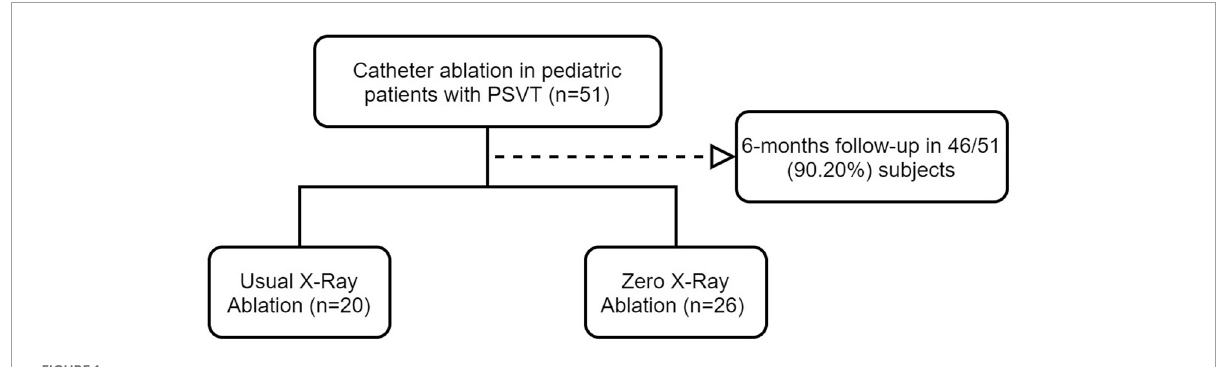
FIGURE1 Flow chart showing the patient selection process.